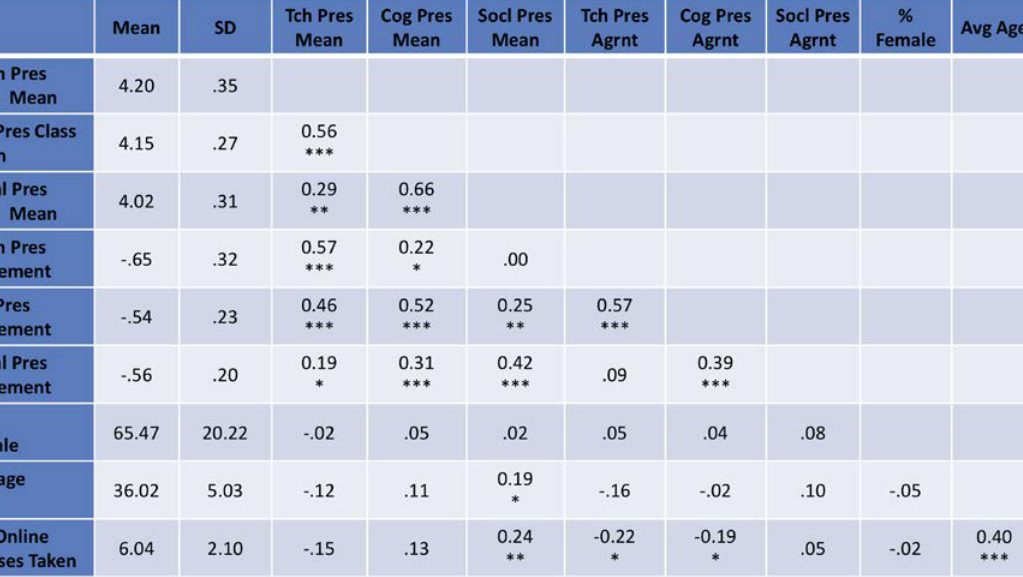
Descriptive Statistics and Intercorrelations Among Class